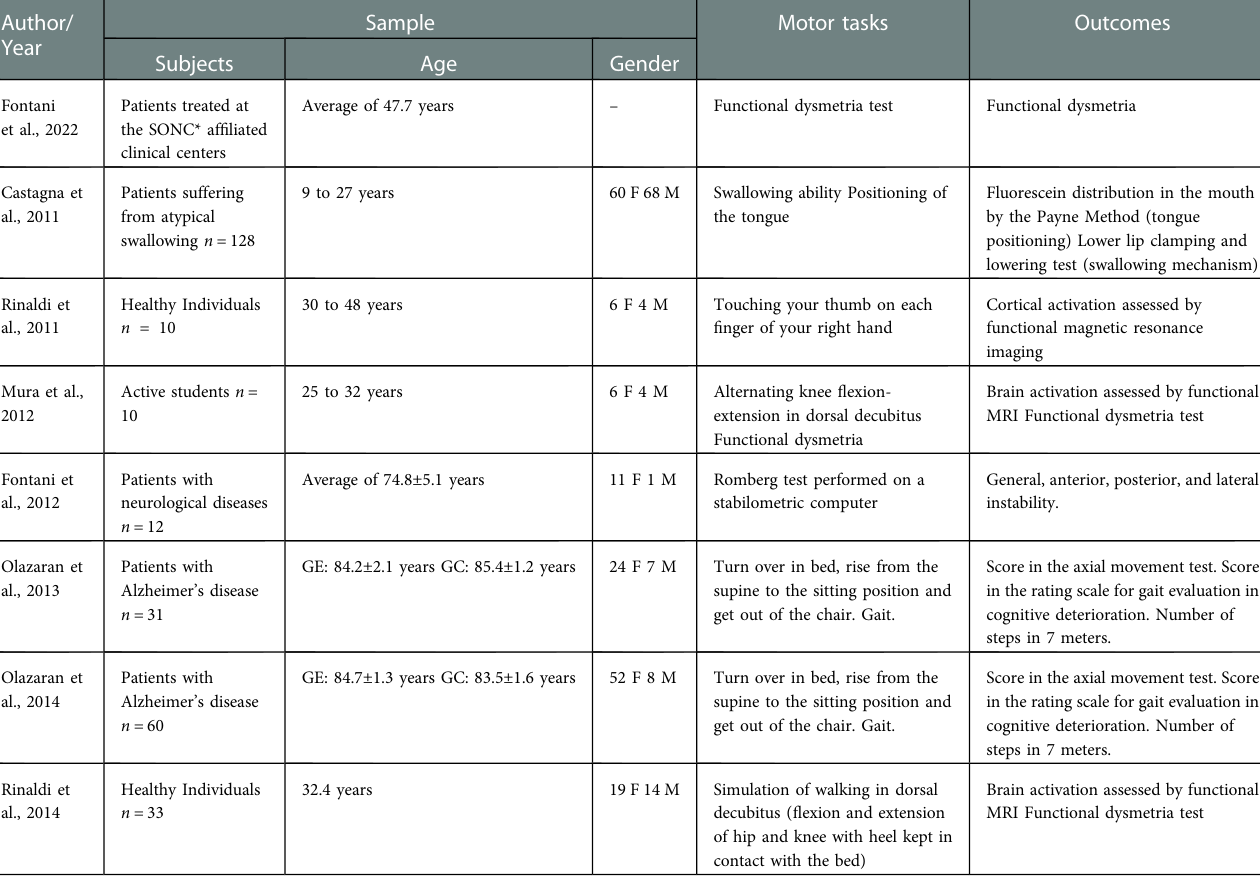
TABLE 3 Characterization of the included clinical studies regarding the sample, motor tasks, and